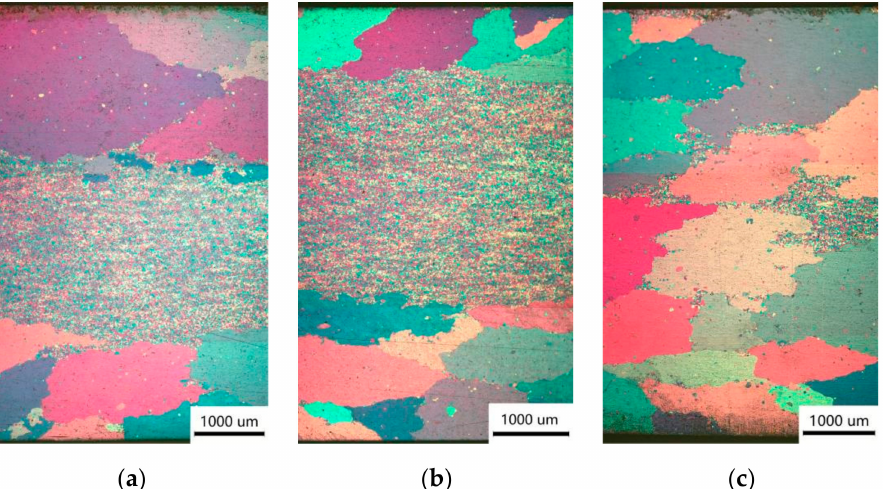
Figure 6. The polarized-light microstructure of as-drawn state 5056 aluminum alloy wires after thermal insulation at 560 ◦ C for different durations: ( a ) 5 min; ( b ) 10 min; ( c ) 20 min.